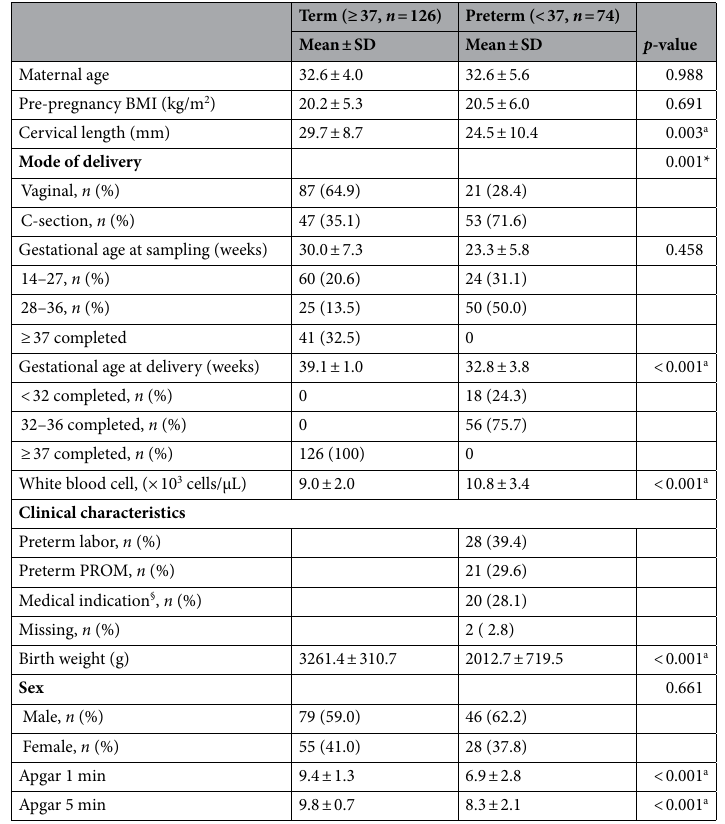
Table 3. Clinical characteristics of participants in the case–control study (n = 200). BMI Body mass index. § Pregnant women with medical indication were diagnosed with preterm labor. a, Student’s t-test. * χ 2 test. Data are shown as the mean ± SD for continuous variables and as n (%) for categorical